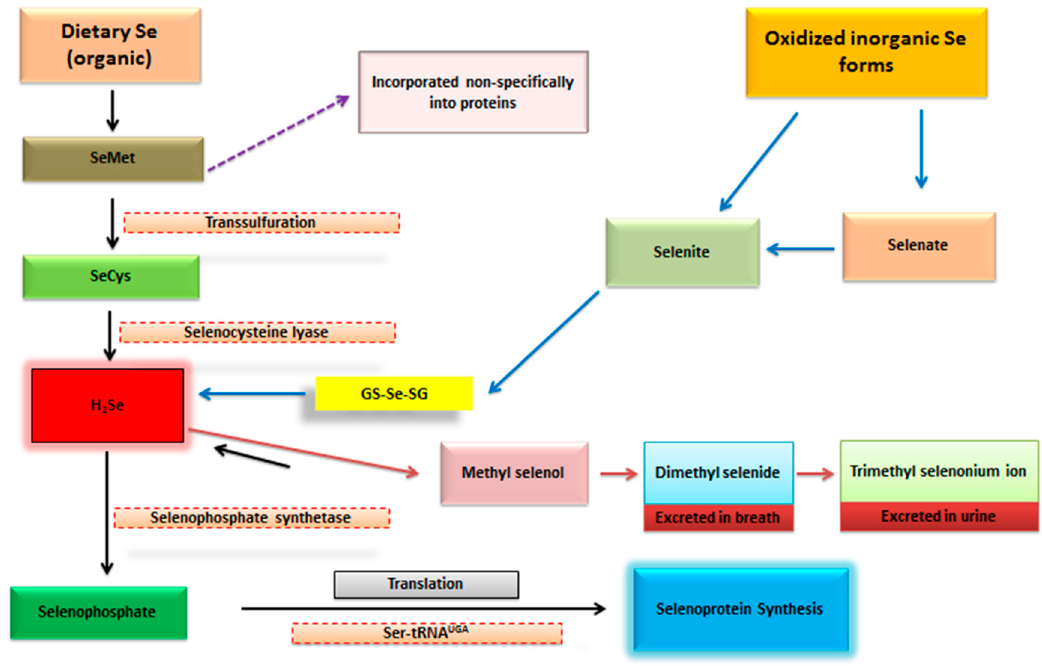
Figure 1. Metabolic pathways of different forms of selenium. Selenomethionine (SeMet) from organic sources (Se-yeast) and other food proteins undergoes transsulfuration reactions and is converted to selenocysteine (SeCys). Selenocysteine is then converted to hydrogen selenide (H 2 Se); this reaction is catalyzed by a substrate-specific enzyme selenocysteine lyase. Hydrogen selenide is converted to selenophosphate via selenophosphate synthetase, and following reaction with tRNA-bound serinyl residues, it produces a SeCys-bound tRNA from which SeCys is inserted co-translationally and further translated to selenoproteins (GPX, SELENOP etc.). Hydrogen selenide could also be methylated and detoxified, and excreted in breath (as dimethyl selenide) and urine (as trimethyl selenonium ion). Alternatively, selenomethionine may also be non-specifically incorporated into proteins such as albumin and hemoglobin in place of methionine. Inorganic forms of Se such as selenate and selenite are metabolized through thiol-dependent reduction reactions, producing hydrogen selenide, which is a starting point for the synthesis of selenoproteins as delineated earlier for organic forms [22,23]. Definitions: GS-Se-SG: selenodiglutathione; GPX: glutathione peroxidase; H 2 Se: hydrogen selenide; Se: selenium; SeMet: selenomethionine; SeCys: selenocysteine; SELENOP: selenoprotein P; Ser-tRNA UGA : seryl tRNA (also Sec-tRNA [Ser] Sec ), and the specific in-frame stop codon (UGA) present in the selenoprotein messenger RNAs. Table 1. Brief description of selenium forms.